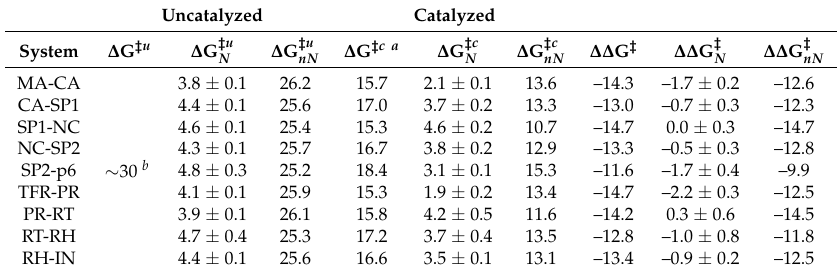
Table 2. Activation free energies in both enzyme-catalyzed and uncatalyzed systems decomposed in terms of NAC and non-NAC contributions. All energies are in kcal/mol. Errors for quantities computed in the simulations are shown. Derived and estimated quantities are reported without